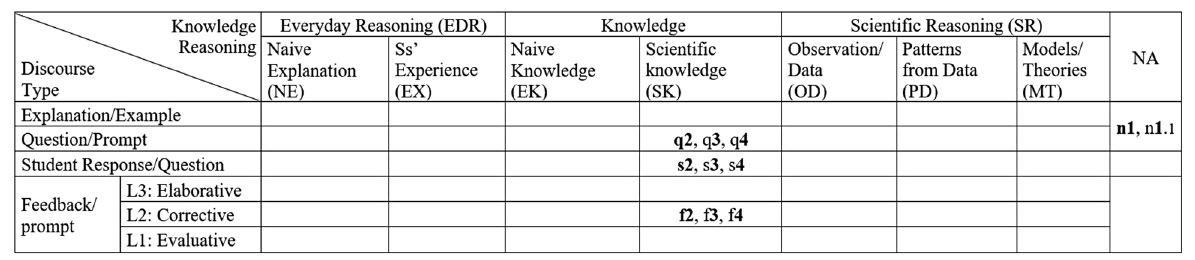
Fig. 5 Ben ’ s CDAT table coded and the